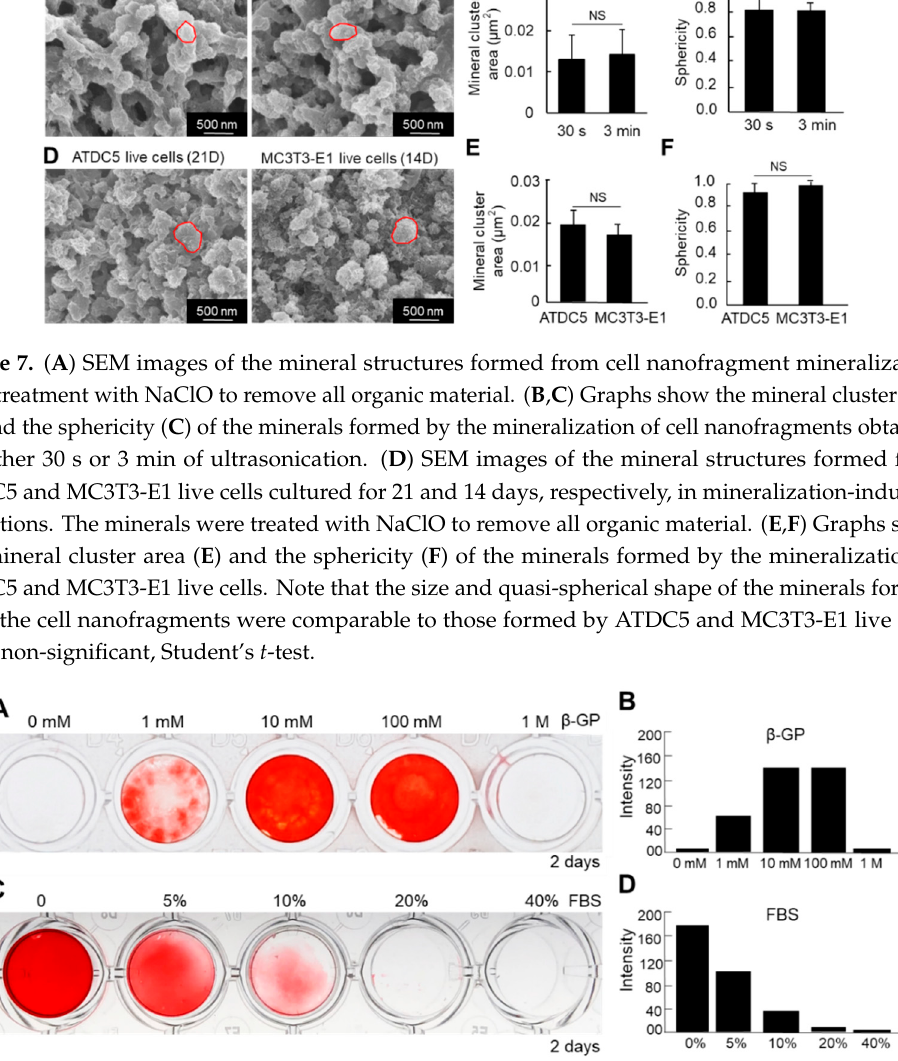
Figure 7. ( A ) SEM images of the mineral structures formed from cell nanofragment mineralization after treatment with NaClO to remove all organic material. ( B , C ) Graphs show the mineral cluster area ( B ) and the sphericity ( C ) of the minerals formed by the mineralization of cell nanofragments obtained by either 30 s or 3 min of ultrasonication. ( D ) SEM images of the mineral structures formed from ATDC5 and MC3T3-E1 live cells cultured for 21 and 14 days, respectively, in mineralization-inducing conditions. The minerals were treated with NaClO to remove all organic material. ( E , F ) Graphs show the mineral cluster area ( E ) and the sphericity ( F ) of the minerals formed by the mineralization of ATDC5 and MC3T3-E1 live cells. Note that the size and quasi-spherical shape of the minerals formed from the cell nanofragments were comparable to those formed by ATDC5 and MC3T3-E1 live cells. NS = non-significant, Student’s t -test.